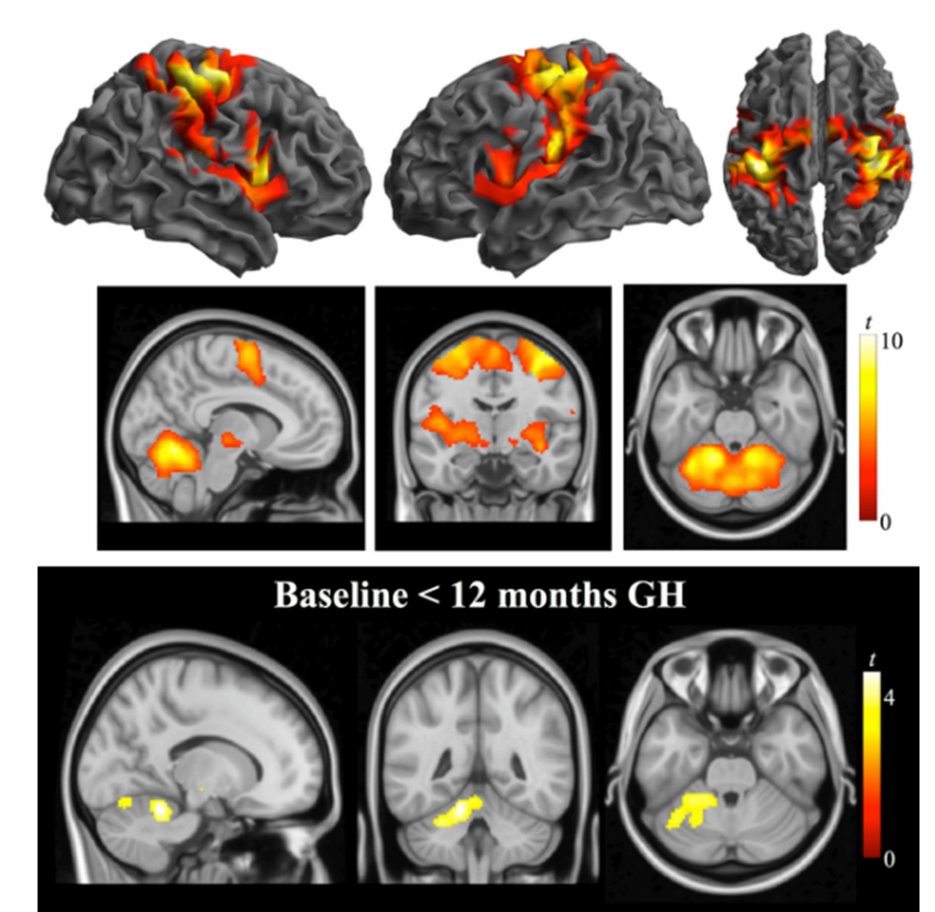
Figure 1. Top and middle rows: Brain activation (one-sample t -test) during the bimanual anti-phase flexion-extension task in patients with Prader–Willi syndrome 12 months after the initiation of rhGH treatment. The functional data are displayed on the lateral and dorsal cortical surfaces (white background) and superimposed on a high-resolution anatomical template (sagittal, coronal, and axial views, respectively; black background) using SPM. Bottom row: Differences in whole-brain activation between baseline and 12 months after the initiation of rhGH treatment (paired-sample t -test). Activations are thresholded at P FWE -corrected < 0.05. Color bars represent t -values. Right in axial and coronal views corresponds to the right